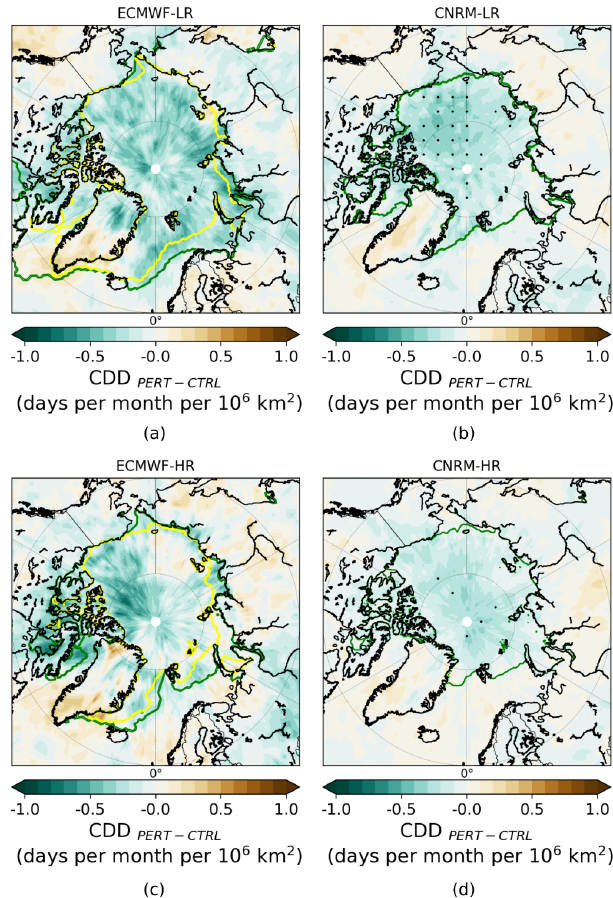
Figure 12. Ensemble mean changes (PERT − CTRL) in summer (JAS) consecutive-dry-day duration scaled by the amount of sea ice extent loss in ECMWF-LR (a) , CNRM-LR (b) , ECMWF-HR (c) and CNRM-HR (d) . The dots show where the response is statisti- cally significant according to a 10% level FDR test associated with a Kolmogorov–Smirnov test. The green and yellow lines represent the sea ice edge (15% ice concentration) for CTRL and PERT, re-